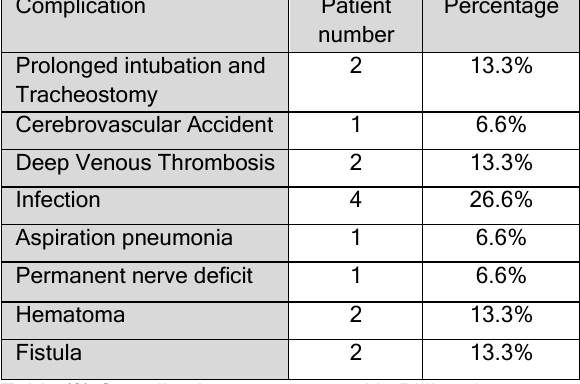
Table (9) Complications encountered in PNI